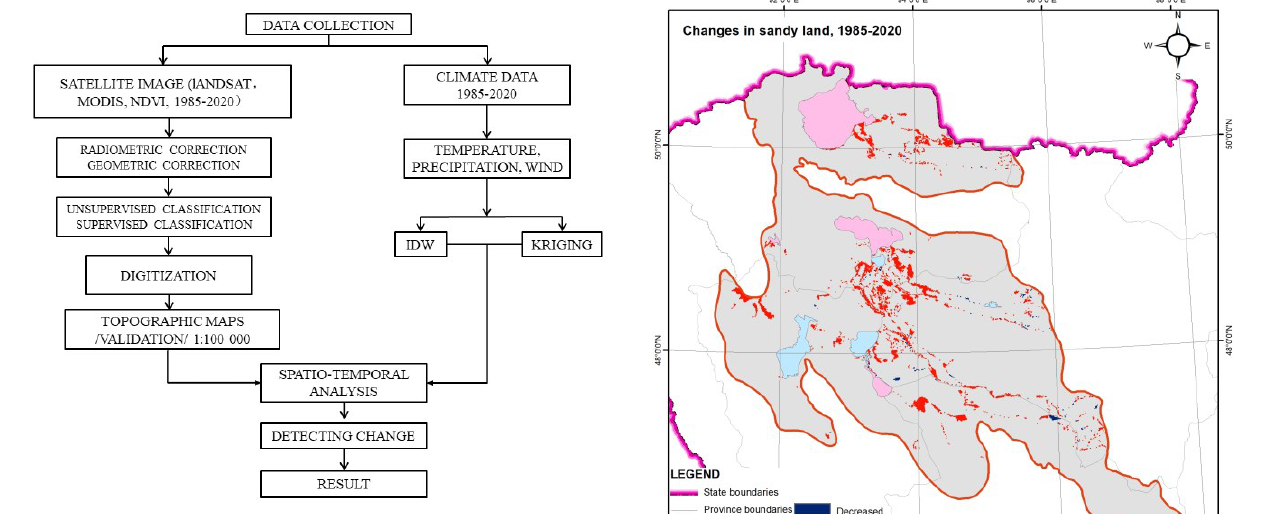
Figure 2. General scheme of research methodology.